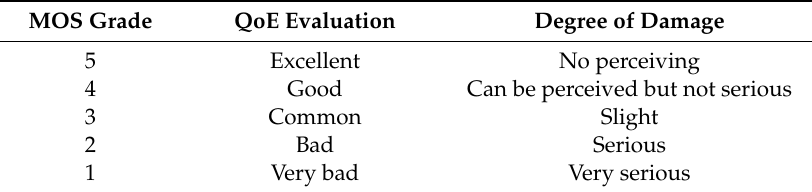
Table 2. The MOS (Mean Opinion Score) evaluation standard. MOS